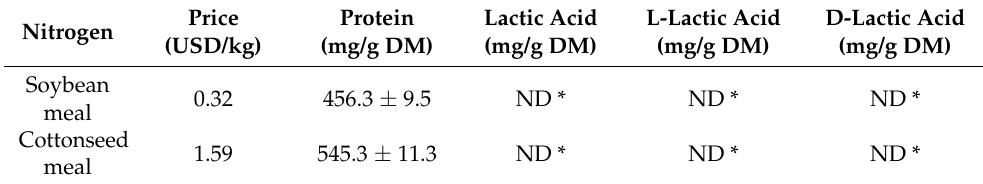
Table 3. Characterization of cottonseed and soybean